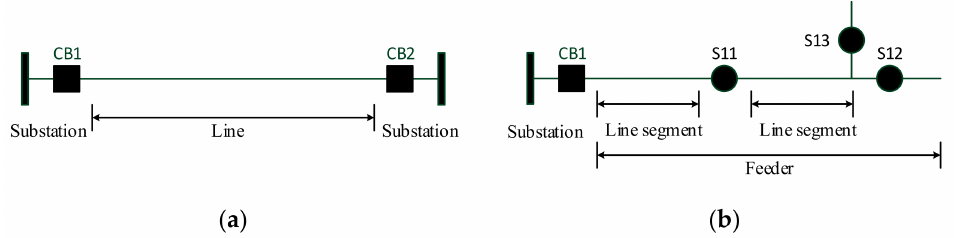
Figure 1. Power line: ( a ) transmission line; ( b ) distribution